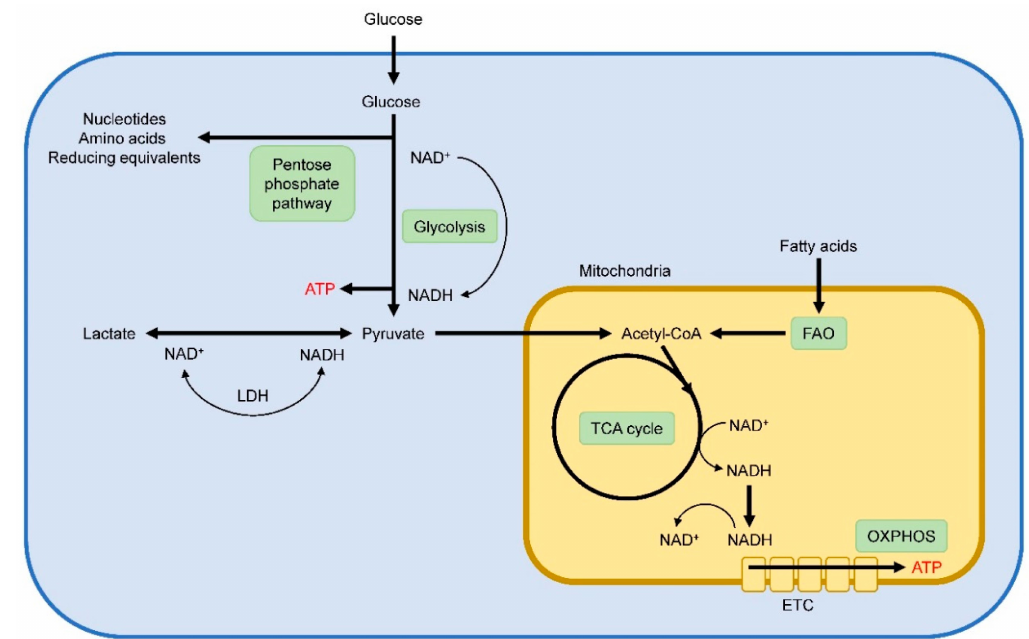
Figure 1. Schematic overview of main metabolic pathways within